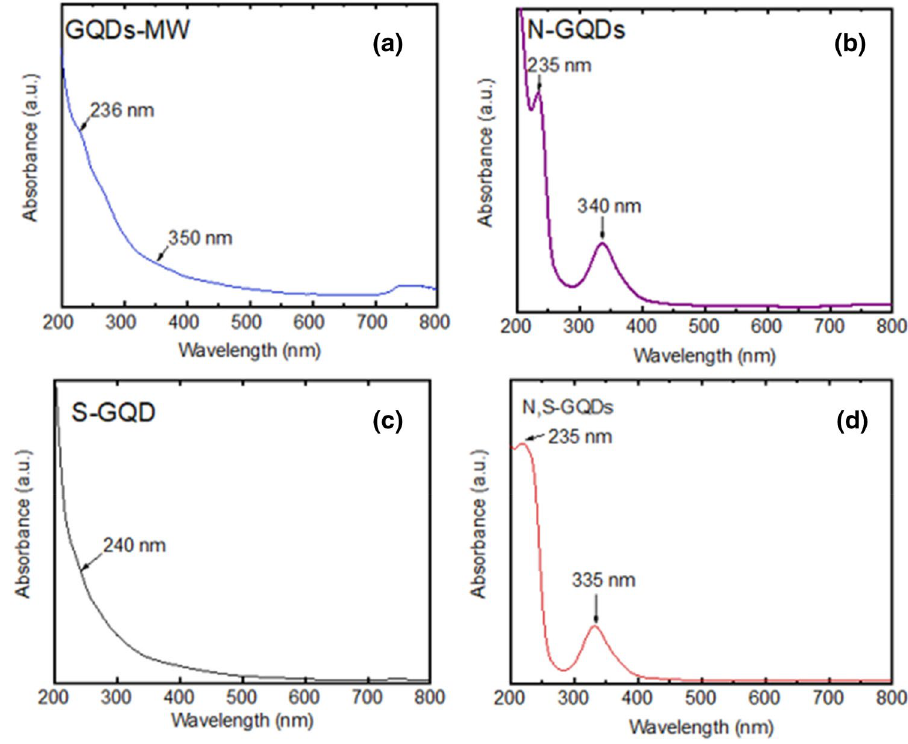
Figure 2. UV–Vis spectra of ( a ) Pristine GQDs, ( b ) N-GQDs, ( c ) S-GQDs and ( d ) N,S-GQDs. Measurements were taken from 200 to 800 nm at room temperature.